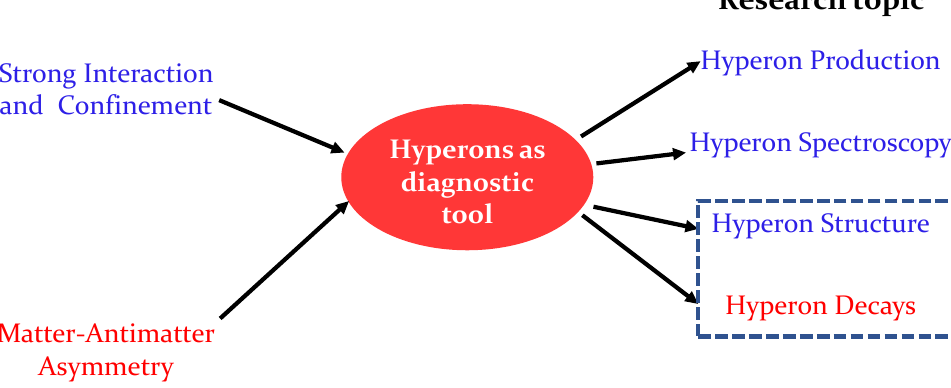
Figure 2: Conceptual map of hyperon physics topics, showing how the two over- arching fundamental questions (left) can be approached by a common diagnostic tool, i.e. hyperons (middle). From this, the different subtopics emerge (right). The colour-coding indicates which questions are related to which research and the dashed rectangle marks the focus of these